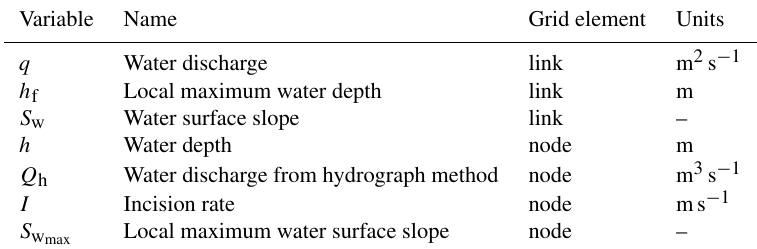
Table 1. List of variables used in the OverlandFlow and DetachmentLtdErosion. For each variable, the name, grid element, and units are given.